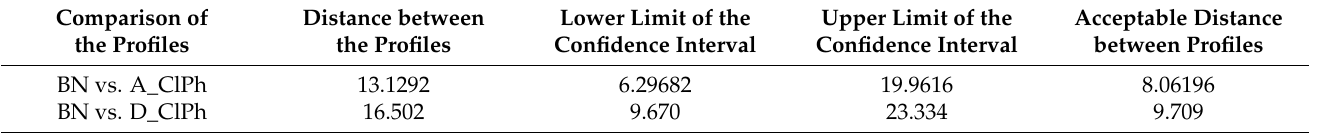
Table 8. Mahalanobis distance